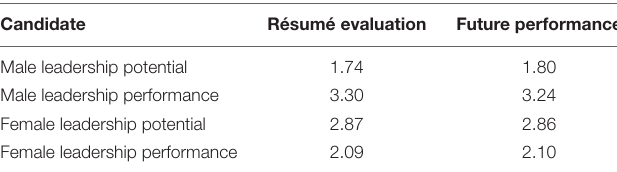
TABLE 2 | Mean rank for each candidate for résumé evaluation and future performance (Experiment